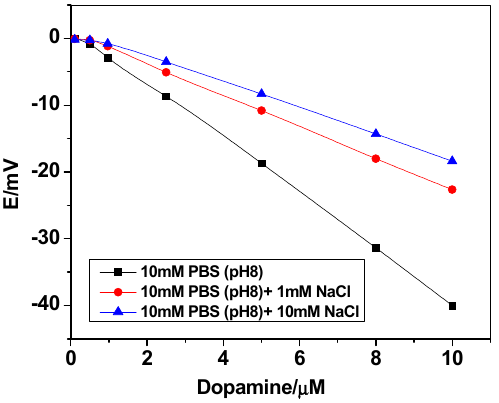
Figure 5. Dynamic potentiometric responses of screen-printed electrodes towards neutral dopamine in 10-mM phosphate buffered solution (PBS)buffer at pH 8. Inset shows the measuring calibration plot for dopamine.